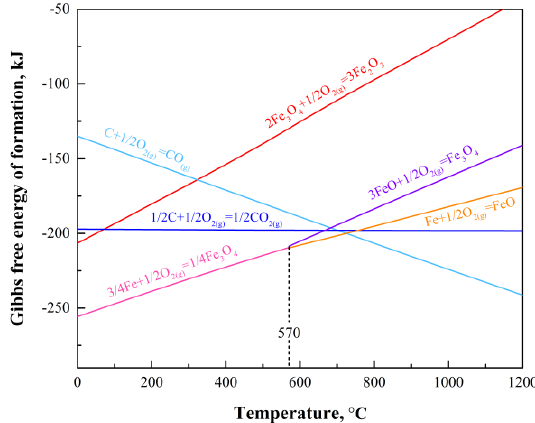
Figure 1. Relationship between temperature and Gibbs free energy of formation of oxides.